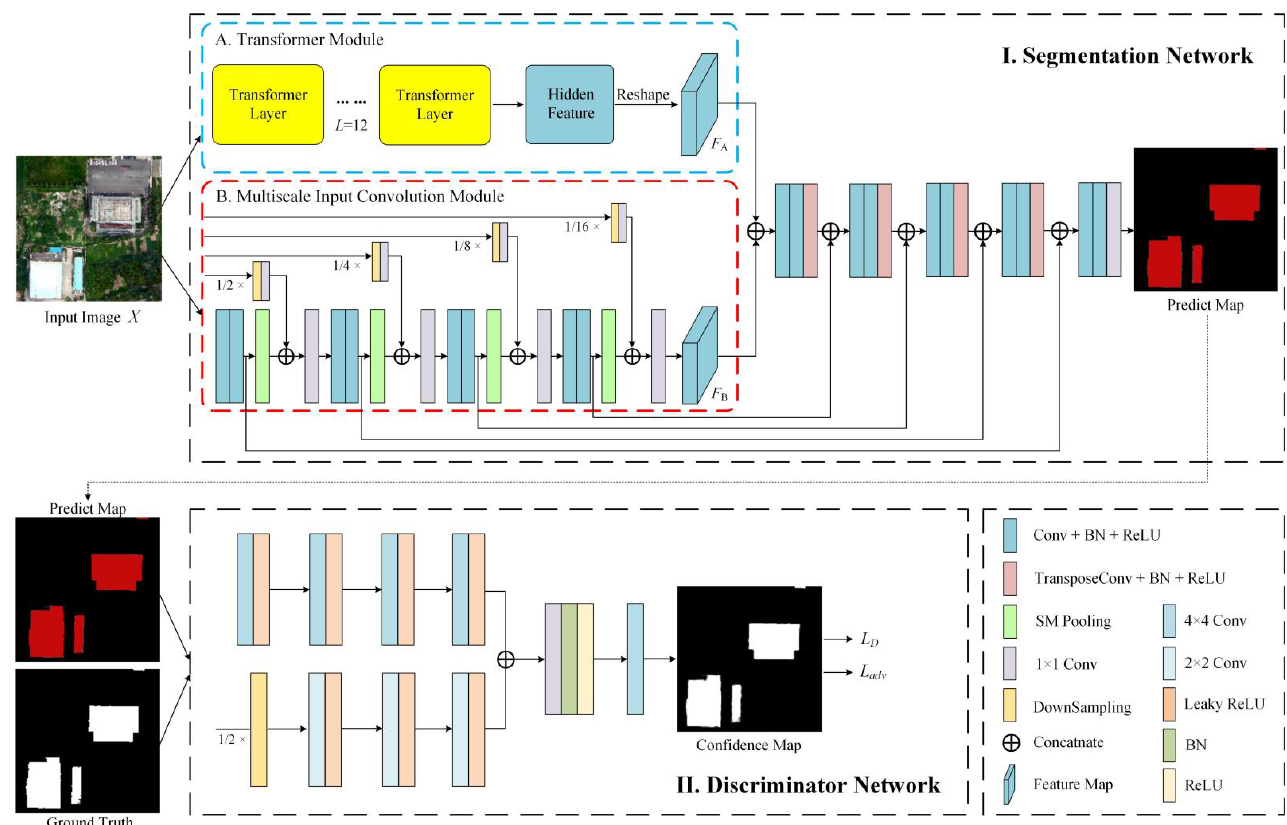
Figure 2. Architecture of TRANet.